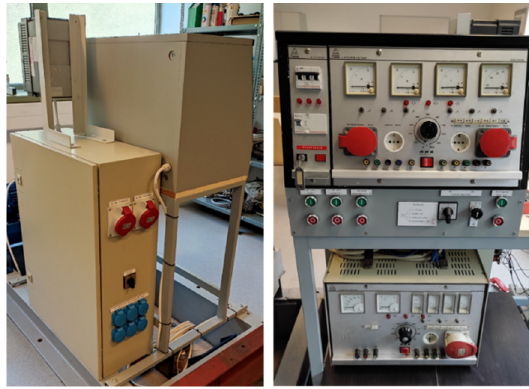
Figure 7. The electrical switch cabinet and control